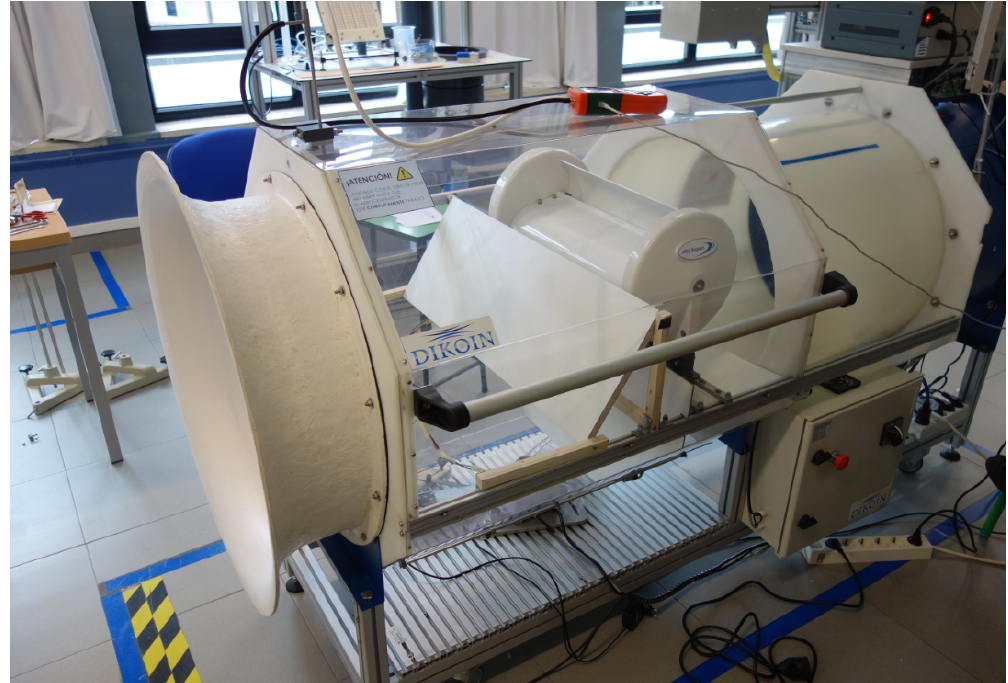
Figure 6. The Savonius turbine inside the wind tunnel with the inferior vane.